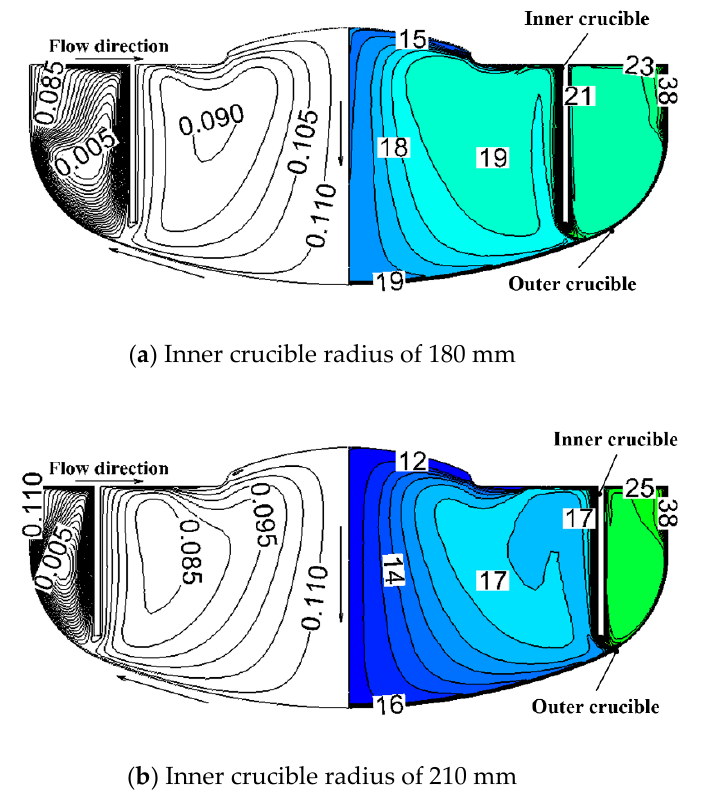
Figure 7. The melt flow patterns (left) and O distributions (right, ppma) in the melt: ( a ) the inner crucible radius is 180 mm, ( b ) the inner crucible radius is 210 mm.